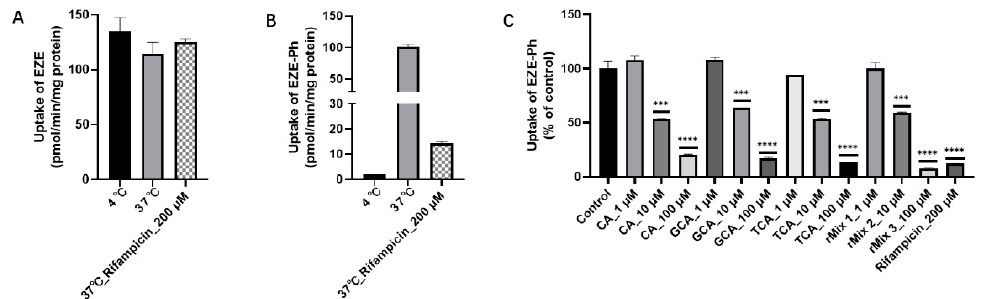
Figure 7. Uptake of EZE ( A ) and EZE-Ph ( B ), and inhibitory effects of bile acids and rifampicin on EZE-Ph uptake ( C ) by rat primary hepatocytes over 10 min. Data are expressed as mean ± S.D. ( n = 3). *** p < 0.001 and **** p < 0.0001 compared with control.